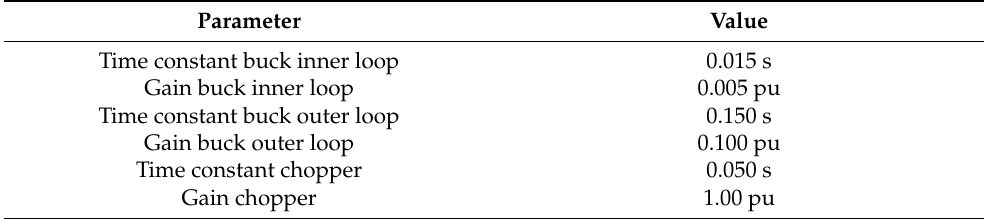
Table A1. Values of the time constants and gains used in the PI controllers of the chopper and buck converter in Scenario 1.